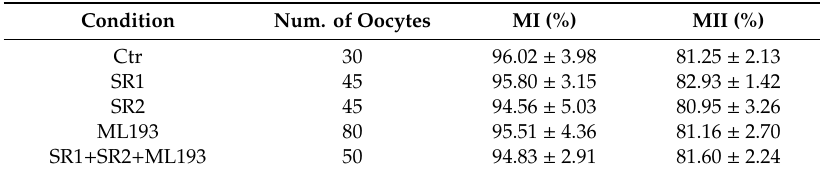
Table 1. Percentages of oocytes at MI or MII stage after in vitro maturation (IVM) in the presence or absence (Ctr) of CBRs antagonists.